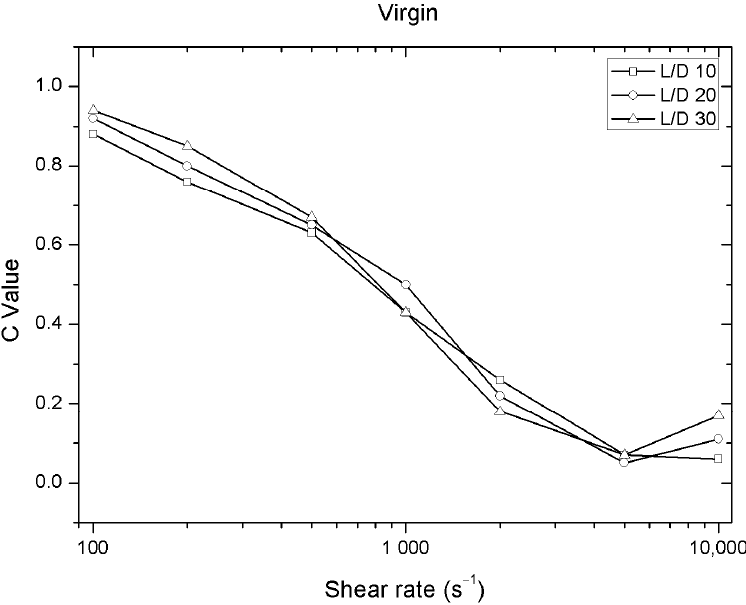
Figure 5. Evolution of C values versus shear rate for different nozzles length of the Solanyl ® at 140 °C. The value of C is indicative of the rate at the pressure increases. This value can be affected by the presence of particles in the polymer matrix. C values of CB 120 and virgin polymer are very similar, but in the case of the smaller particle size (CB 120), the dispersion of C values increase when 2000 s − 1 of shear rate is employed. This dispersion is greater in samples with 30 wt.% of wood flour and it is more evident in 1000 s − 1 of shear rate, as can be seen in Figure 6.